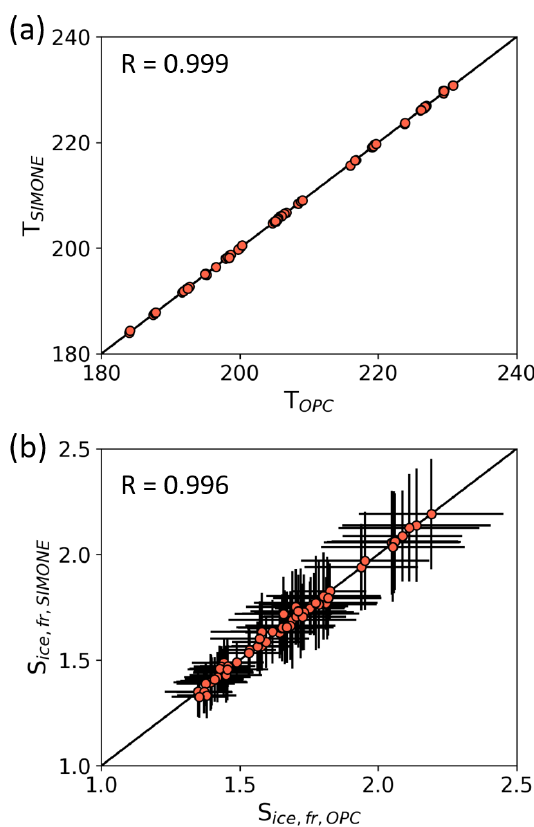
Figure A1. Comparison of the homogeneous freezing onset temperature ( T ice , panel a ) and ice saturation ratio ( S ice , fr , panel b ) derived from the SIMONE and OPC data. The respective Pearson’s correlation coefficients are R = 0.999 and R =